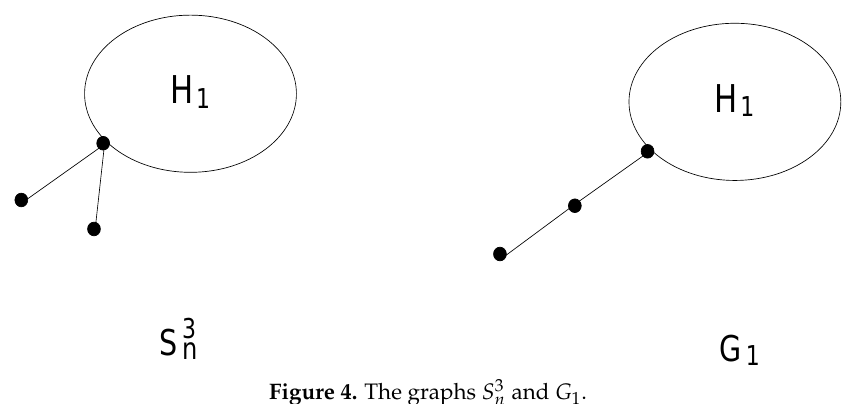
Figure 4. The graphs S 3 n and G 1 .